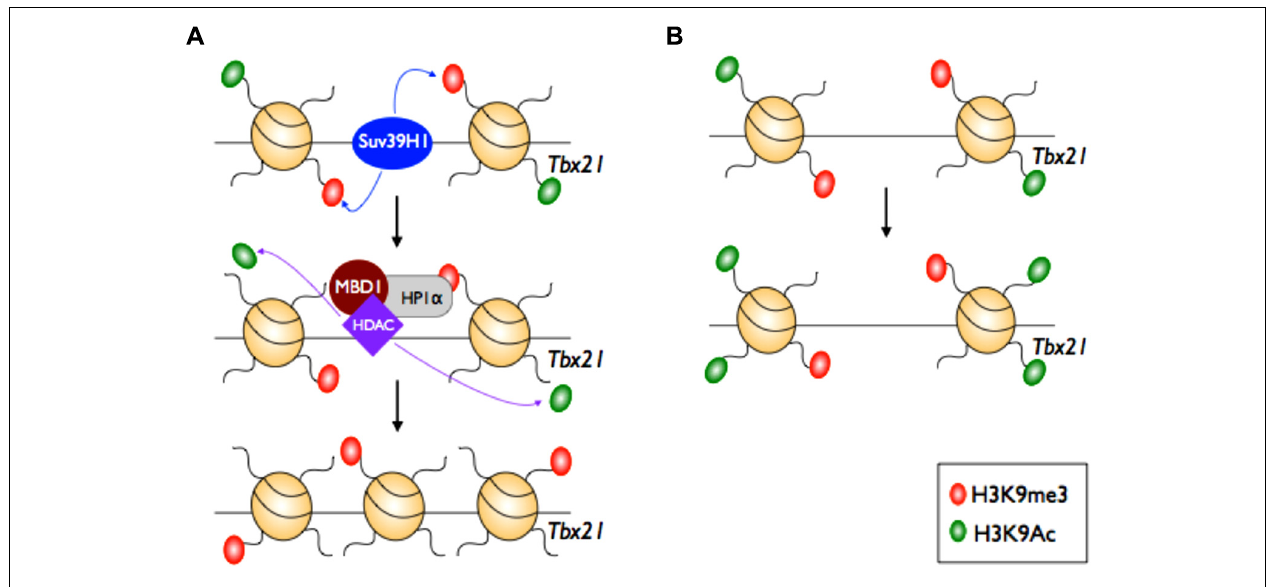
FIGURE 5 | Epigenetic maintenance of T H 2 lineage commitment. In the T H 2 cell subset, the master regulator of T H 1 cells ( Tbx21 ) is silenced. The histone methylase Suv39H1 adds the repressive H3K9me3 mark at the Tbx21 locus. This initiates recruitment and docking of heterochromatin